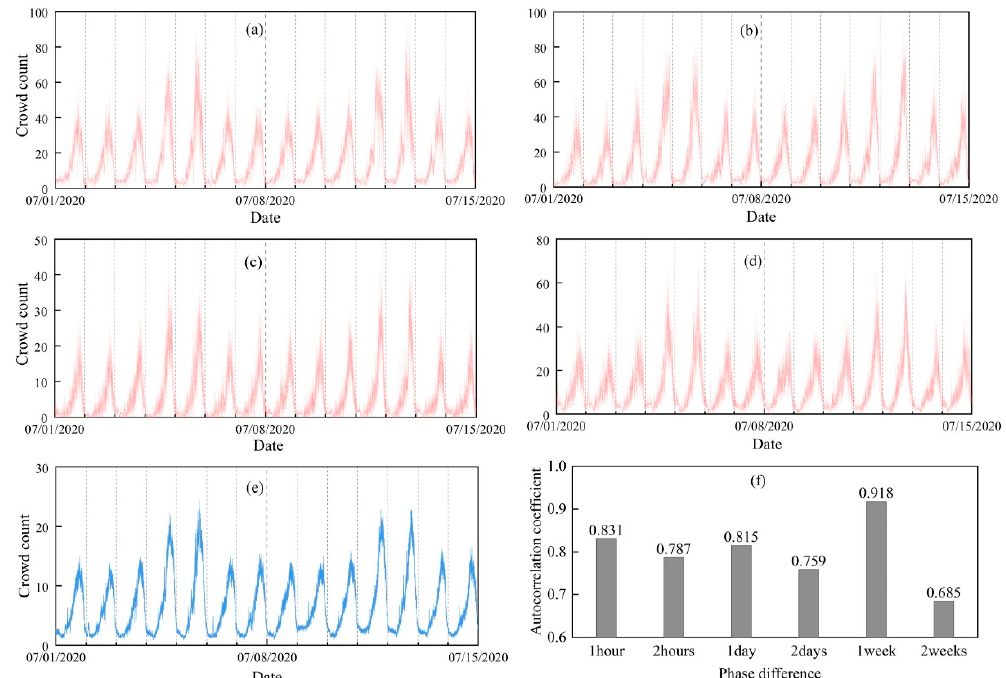
Figure 2. ( a – d ) Pedestrian flow pattern of some typical detectors at the junctions (i.e., detector 6, 8, 13 and 16); ( e ) the mean pedestrian flow pattern of the study area; ( f ) the autocorrelation coefficient under various phase difference.